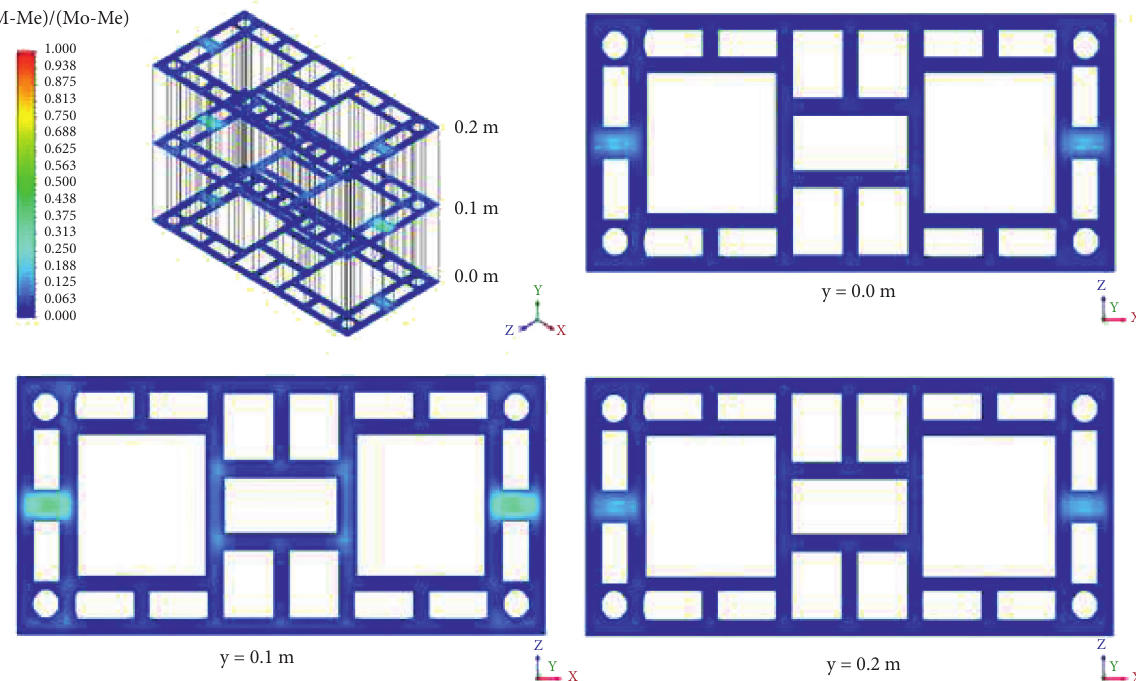
Figure 17: Dimensionless moisture field in the brick, at different planes XZ with the elapsed time of 15.5 hours ( T � 80 ° C, RH �